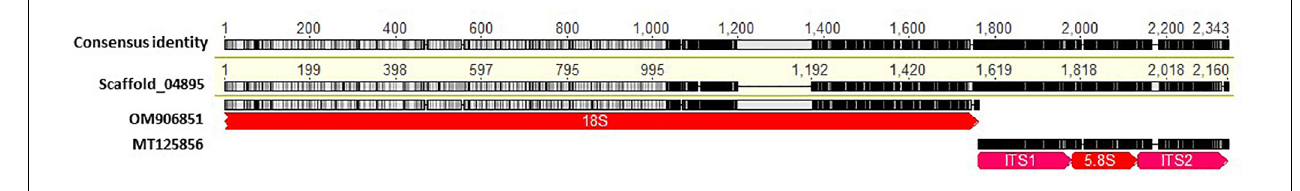
FIGURE 3 | Alignment of 18S (GenBank accession no. OM906851) and ITS (GenBank accession no. MT125856) sequences of Leveillula taurica HNHM-MYC-006405 produced via Sanger sequencing against the sequence of Scaffold-04895 extracted from the genome assembly of the same strain (Assembly project PRJEB36538 from ENA database). nrDNA annotations are depicted by arrowed boxes. Black and gray colors indicate dissimilar and identical nucleotides, respectively, with gaps depicted by horizontal